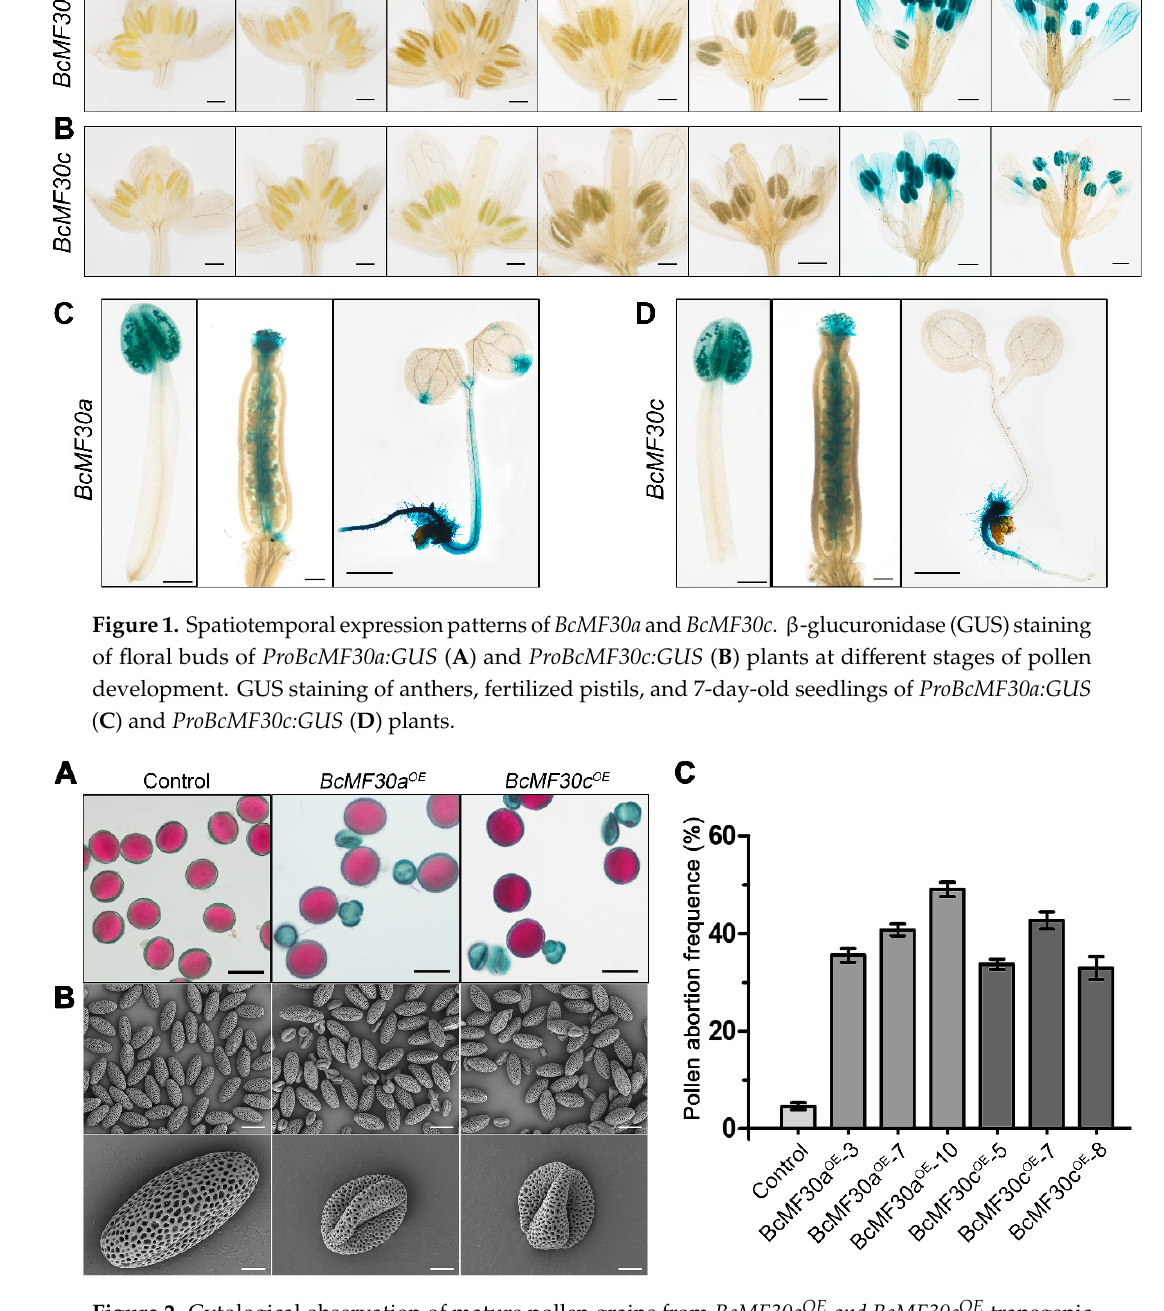
Figure 2. Cytological observation of mature pollen grains from BcMF30a OE and BcMF30c OE transgenic plants of Brassica campestris . Alexander staining ( A ) and scanning electron micrograph (SEM) observation ( B ) of BcMF30a OE and BcMF30c OE mature pollen grains. ( C ) Analysis of pollen abortion frequency in the T 1 lines of BcMF30a OE and BcMF30c OE plants. The values are the mean ± SD (standard deviation). Bars = 25 μ m in ( A ), and 30 and 5 μ m in ( B ).